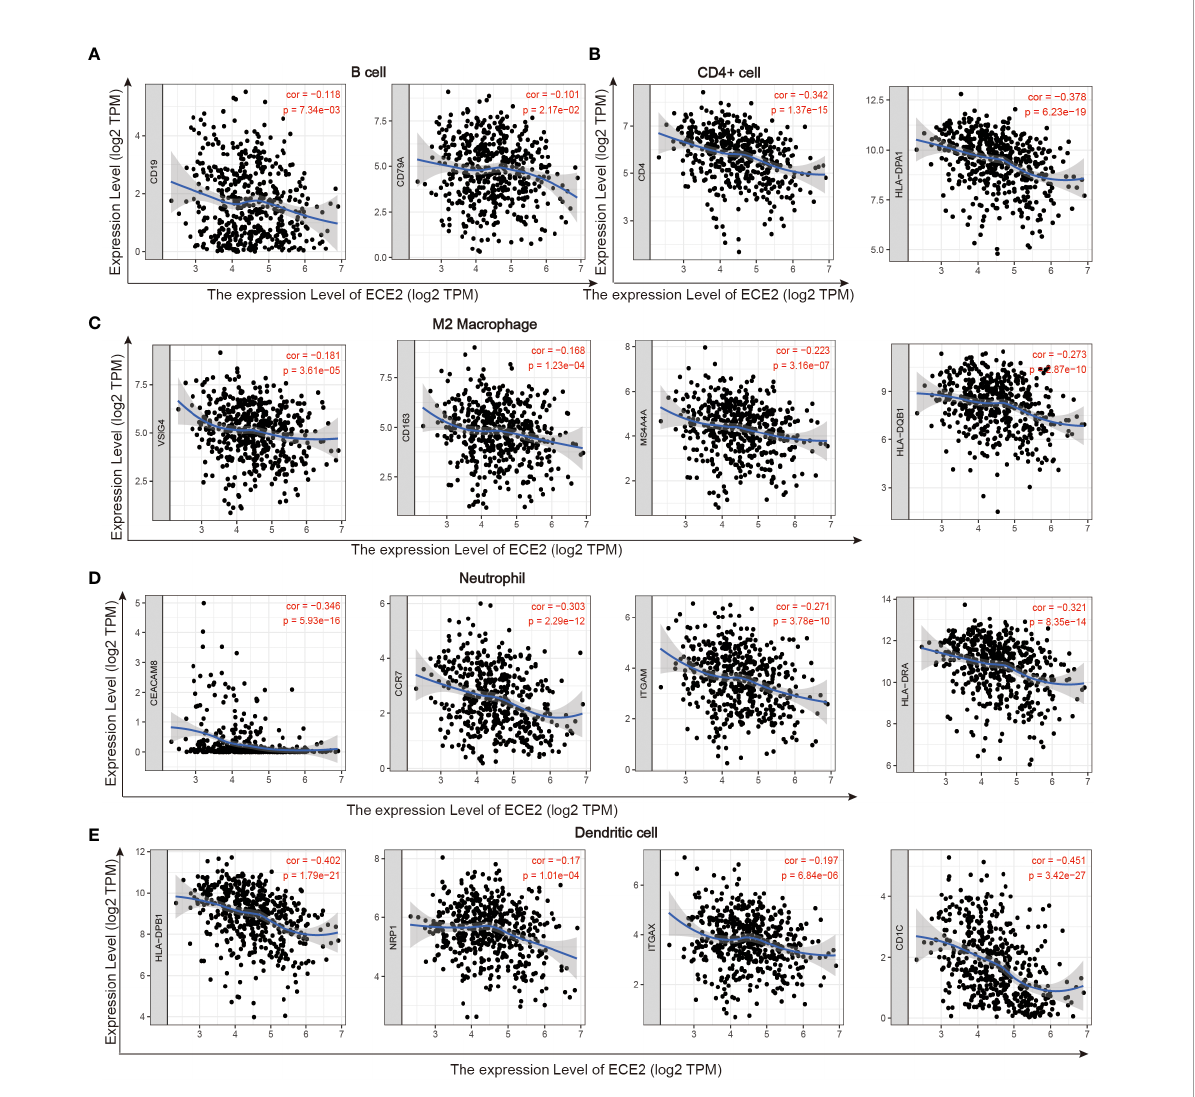
FIGURE 6 TIMER database correlation analysis of ECE2 expression with marker genes of in fi ltrating immune cells in LUAD. (A) B cell (B) CD4+ cell (C) M2 Macrophage (D) Neutrophil and (E) Dendritic